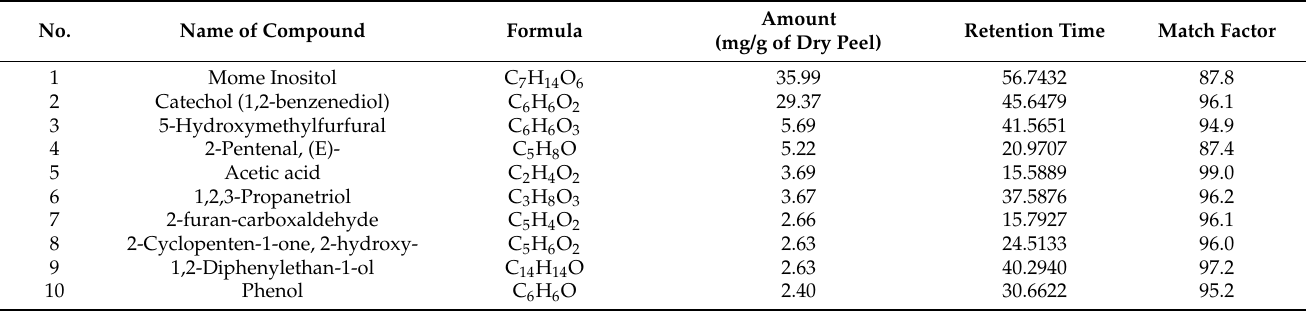
Table 1. Ten major organic compounds identified in rambutan peel extract (RPE).